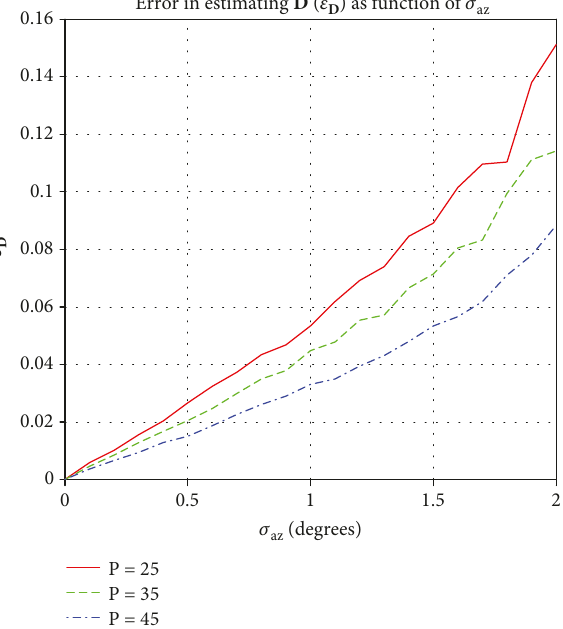
Figure 3: The error in estimating D as a function of the error in estimating the DOAs, using 𝑃 = 25 , 35 , 45 periods, with K = 2 signals per period.